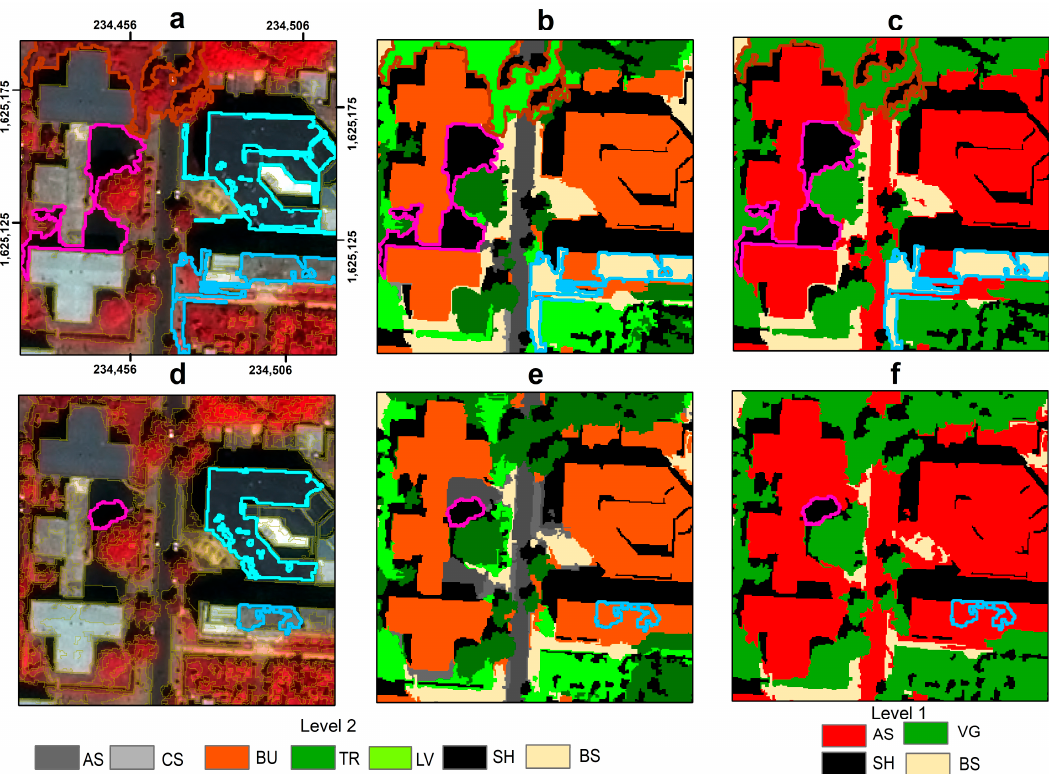
Figure 11. Classification results for the two approaches at two levels from ROI 1. ( a ) Segmentation and highlighted objects from the FT method, ( b ) classification results for Classification Level 2 and ( c ) Classification Level 1 for FT, ( d ) Segmentation and highlighted objects from the LOESS method, ( e ) classification results for Classification Level 2 and ( f ) Classification level 1 for LOESS.